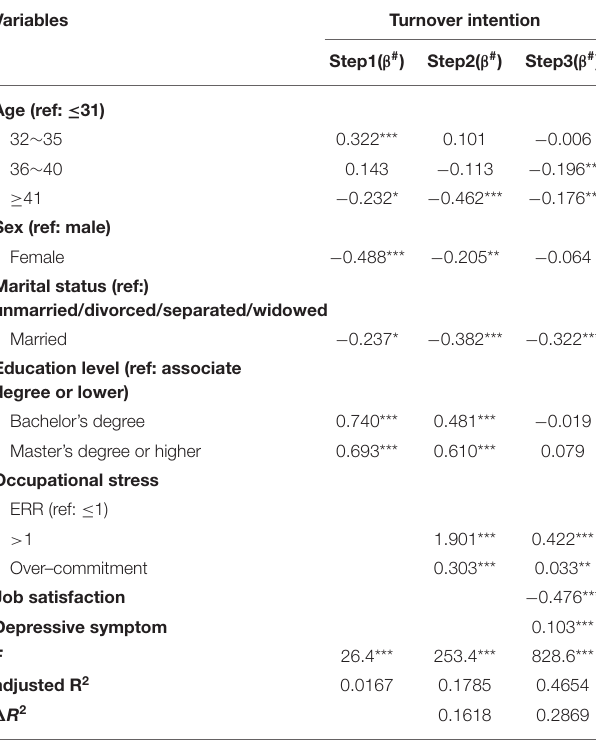
TABLE 3 | The hierarchical linear regression analysis for turnover intention. Variables Turnover